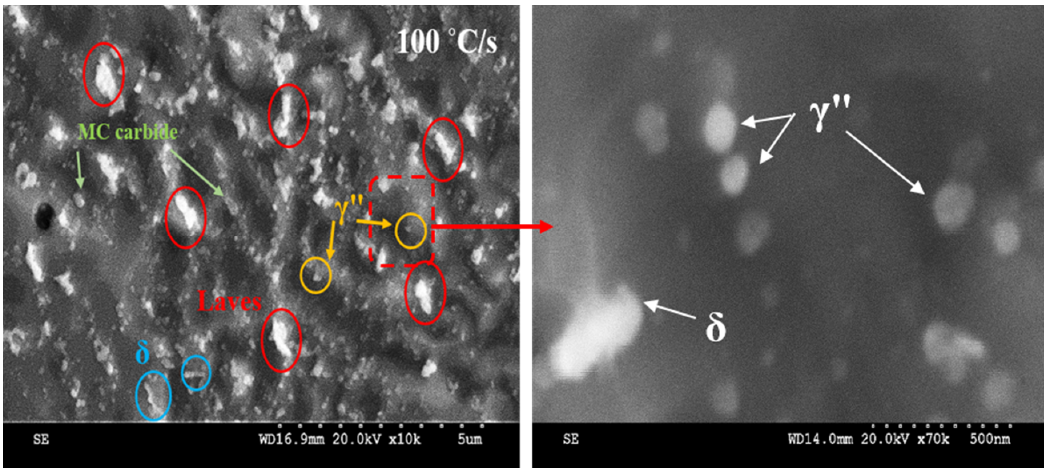
Figure 14. SEM images of the blocky zone show the presence of different precipitates such as semi-spherical γ ״ and δ particles for sample heated to 1000 °C at a rate of 100 °C/s.